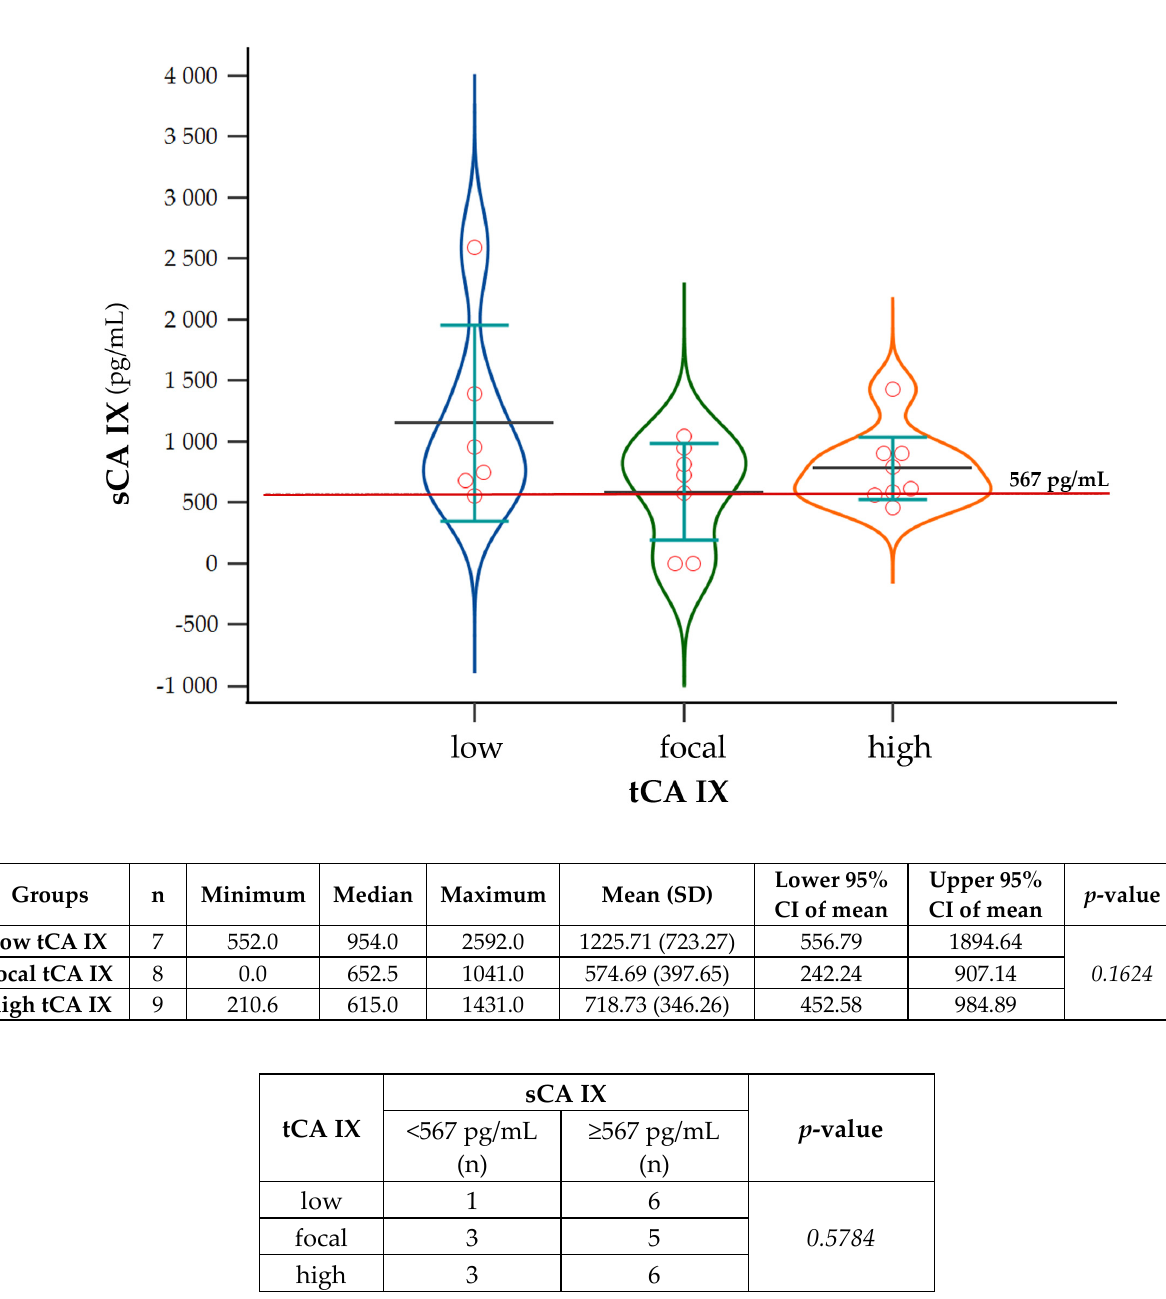
Figure 4. Analysis of sCA IX levels in the plasma of patients with CA IX+ tumor tissue. Violin graphs with dots (plot all data) showing sCA IX levels of patients divided according to CA IX score into groups: low, focal, and high tCA IX. For the evaluation of differences in sCA IX levels between tCA IX groups, the Kruskal–Wallis test with Dunn’s post hoc test was used ( p = 0.1624) . Summary statistical data of sCA IX levels (n= number of patients, minimum, median, maximum, mean with standard deviation (SD), lower and upper 95% CI of mean, and p -value) for each group are displayed in the table below the image. The lower table expresses the association between sCA IX below ( < 567 pg/mL) and above ( ≥ 567 pg/mL) the cut off value with the low, focal, and high tCA IX groups. The statistical evaluation was performed using a chi-squared test. (n)—number of patients.